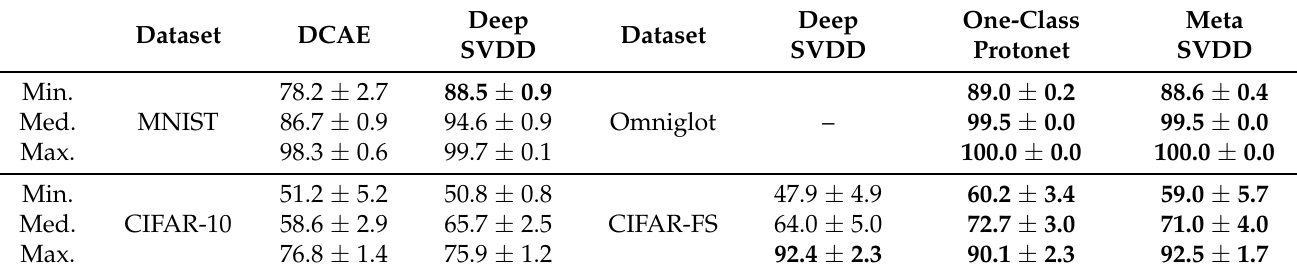
Table 1. Minimum, median and maximum mean AUC alongside their standard deviation for one-class classification methods for 10 repetitions. We highlight in boldface the highest mean and others which are within one standard deviation from it. The results for the many-shot baselines in MNIST and CIFAR-10 are compiled from the table by Ruff et al. [2]. The results for Omniglot and CIFAR-FS are for five-shot one-class